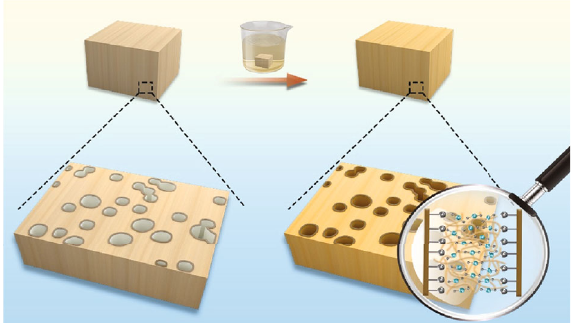
Figure 1: The schematic illustration of manufacturing process of MUG-treated